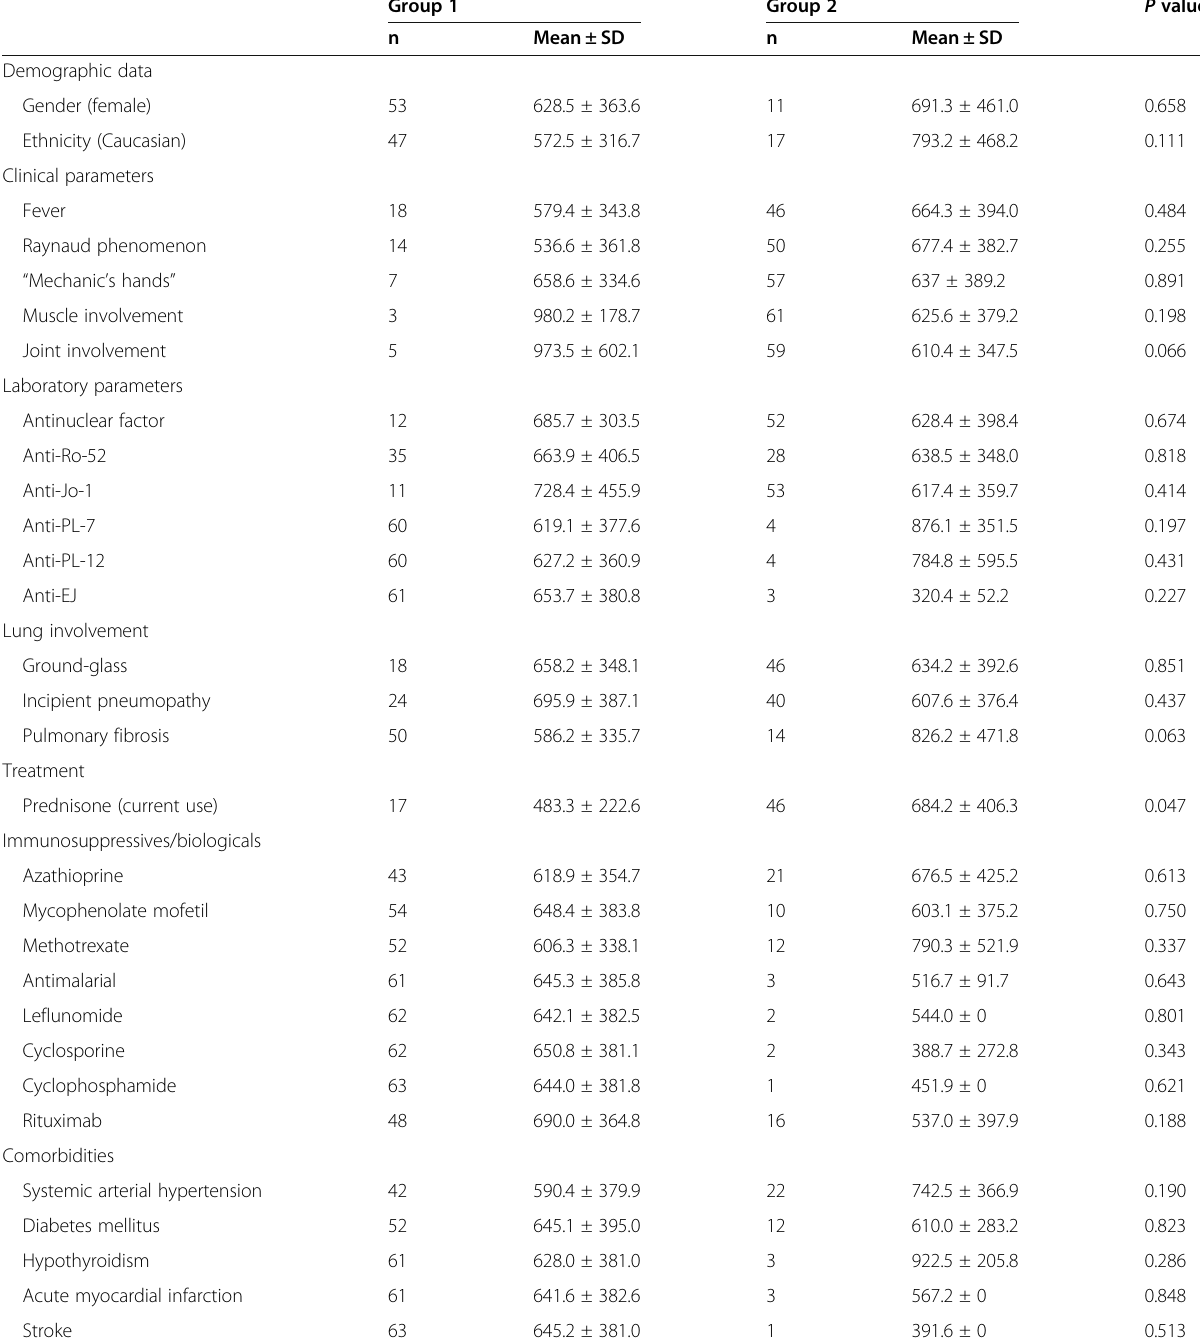
Table 4 Relation between YKL-40 serum levels and others variables (demographic, clinical, laboratory and lung parameters, disease status, and comorbidities) of the patients with antisynthetase syndrome Group 1 Group